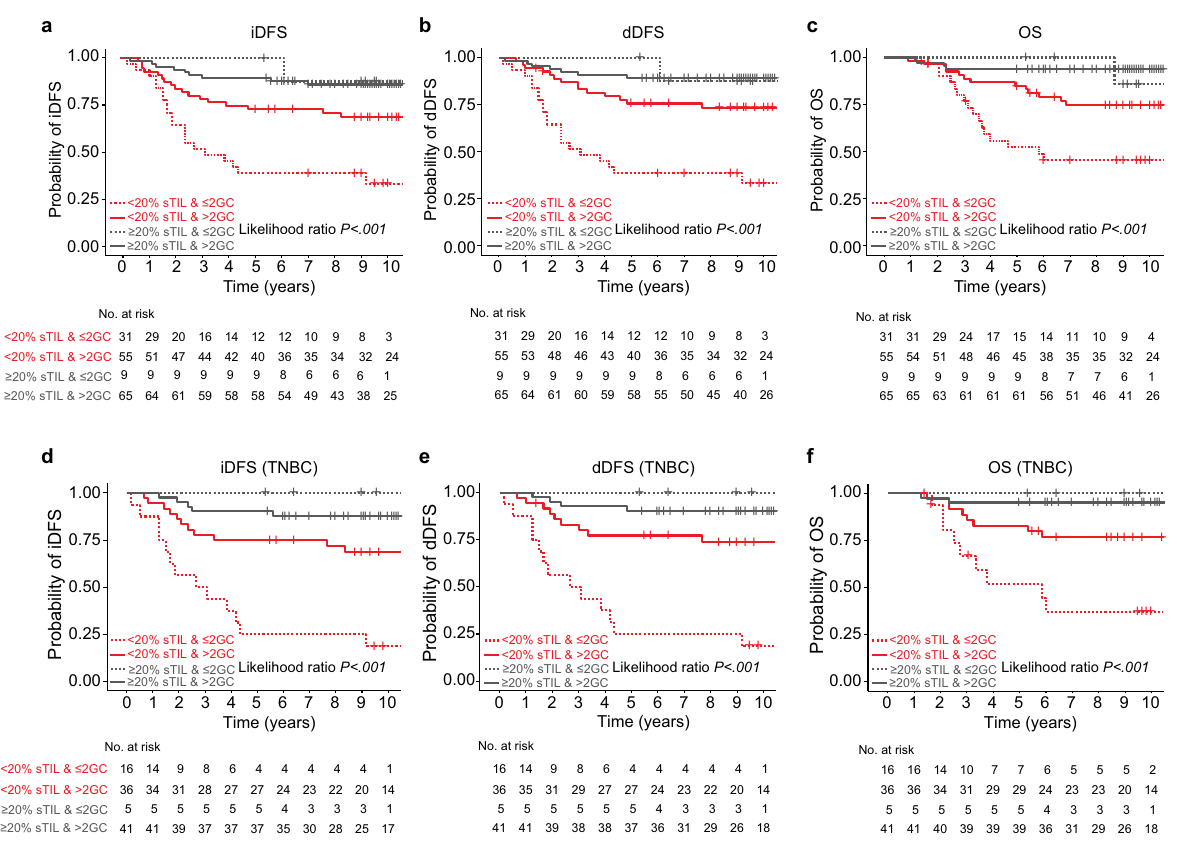
Fig. 4 Association between germinal center formation in lymph nodes and prognosis in HR-negative breast cancers. Kaplan – Meier curves: a invasive Disease-Free Survival (iDFS), b distant Disease-Free Survival (dDFS), c Overall Survival (OS), d invasive Disease-Free Survival (iDFS) in TNBC, e distant Disease-Free Survival (dDFS) in TNBC, and f Overall Survival (OS) in TNBC, according to stromal tumor-in fi ltrating lymphocytes (TILs) and germinal center (GC) number. Patient groups were strati fi ed by TILs ( ≥ 20%, <20%) and the number of GCs ( ≤ 2GCs, > 2GC) in all assessed cancer-free LNs, as categorical variables. P values correspond to likelihood ratio